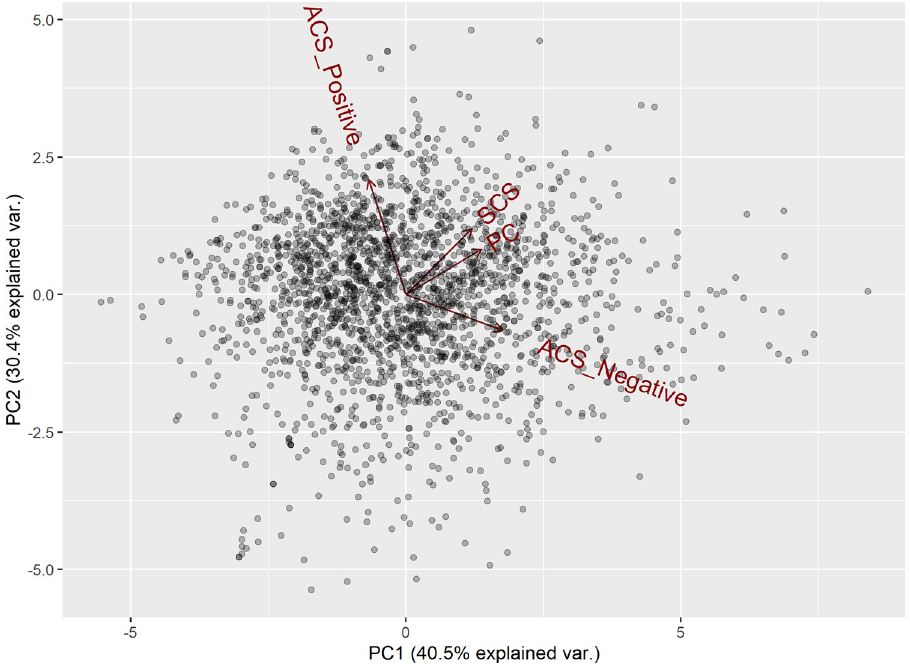
Fig 1. Biplot of principal component 1 and principal component 2.